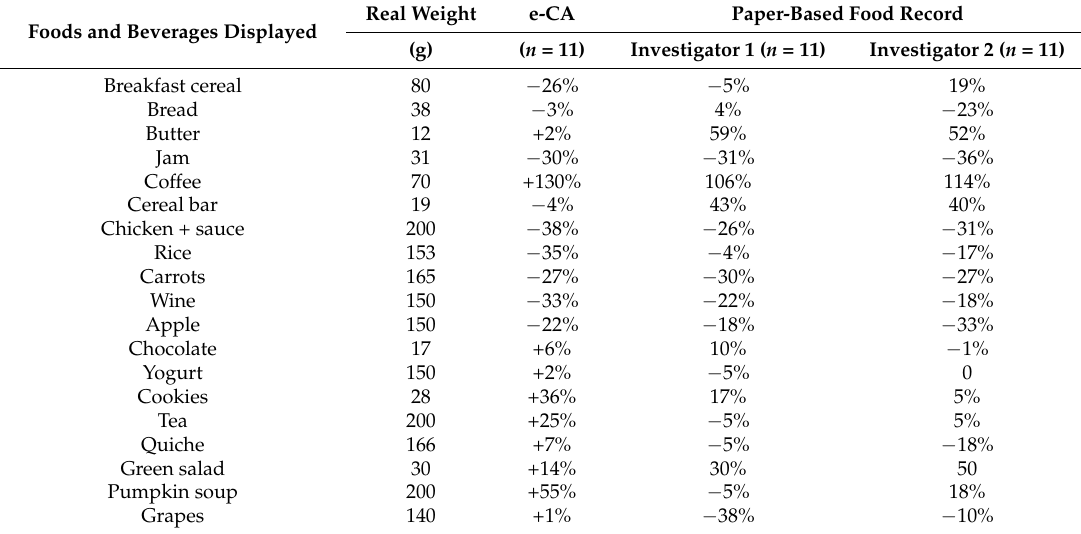
Table 3. Percentage of over or underestimation of the weight of displayed portions of 20 items using e-CA or a paper-based food record, analyzed by two independent investigators, and compared to real